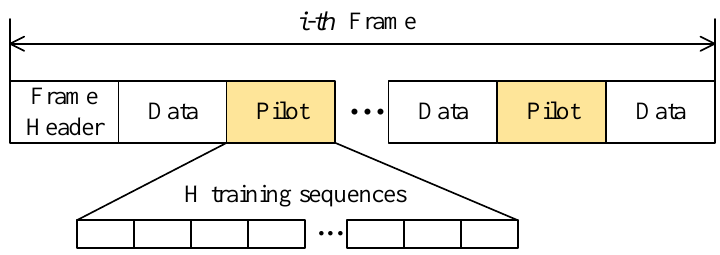
Figure 4. Data transmission frame structure with noise reduction